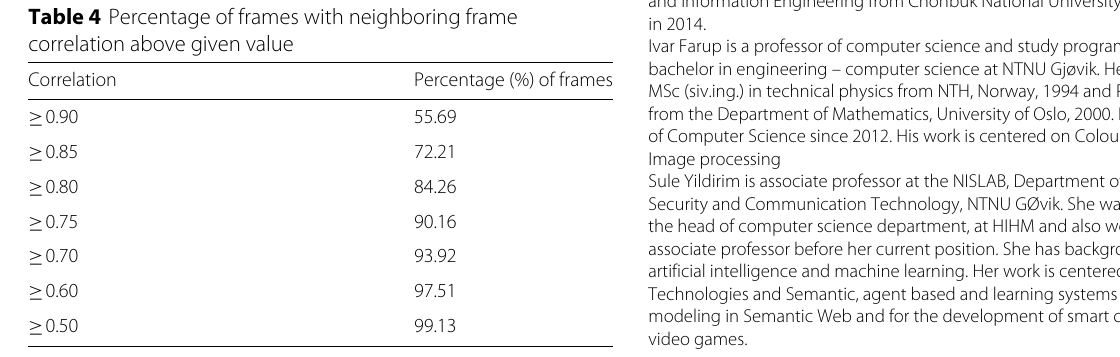
Table 4 Percentage of frames with neighboring